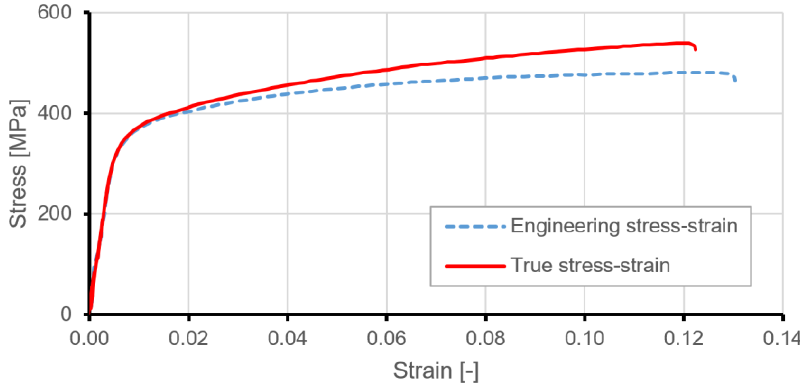
Figure 3. Nominal stress–strain curves for 2024 aluminium alloy.